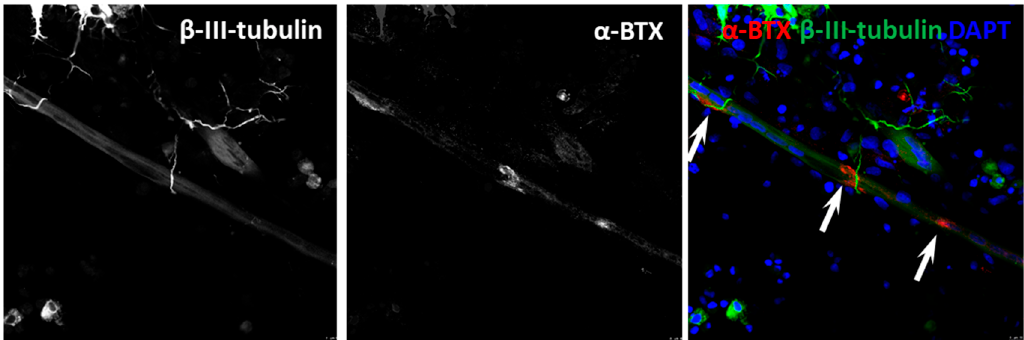
Figure 4. Characterisation of neuromuscular junction formation at Day 14. Representative image of co-culture stained for β -III-tubulin (green), alpha-bungarotoxin ( α -BTX) (red) and DAPI (blue). Scale bar = 5 µm. White arrows indicate the NMJ formation and the multiple innervation.